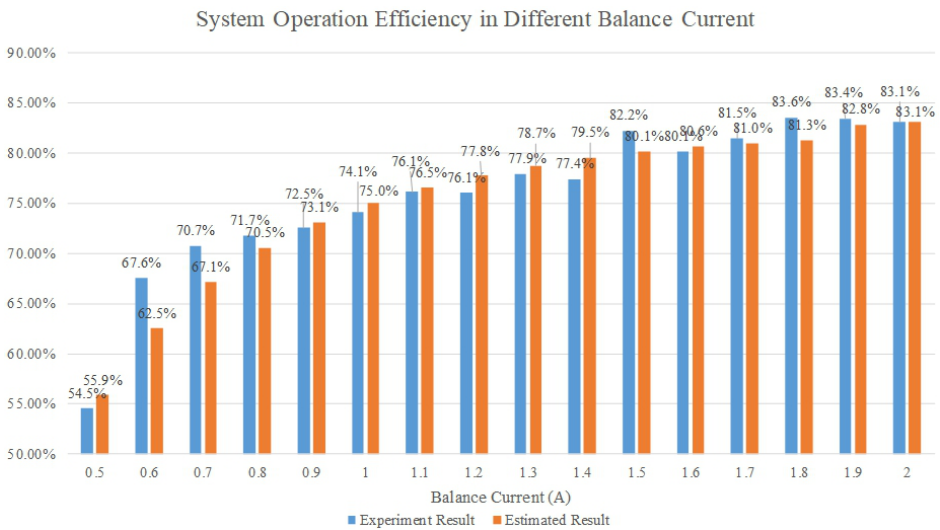
Figure 10. Comparison between the measured results of the balancing system and estimated results of the loss model.